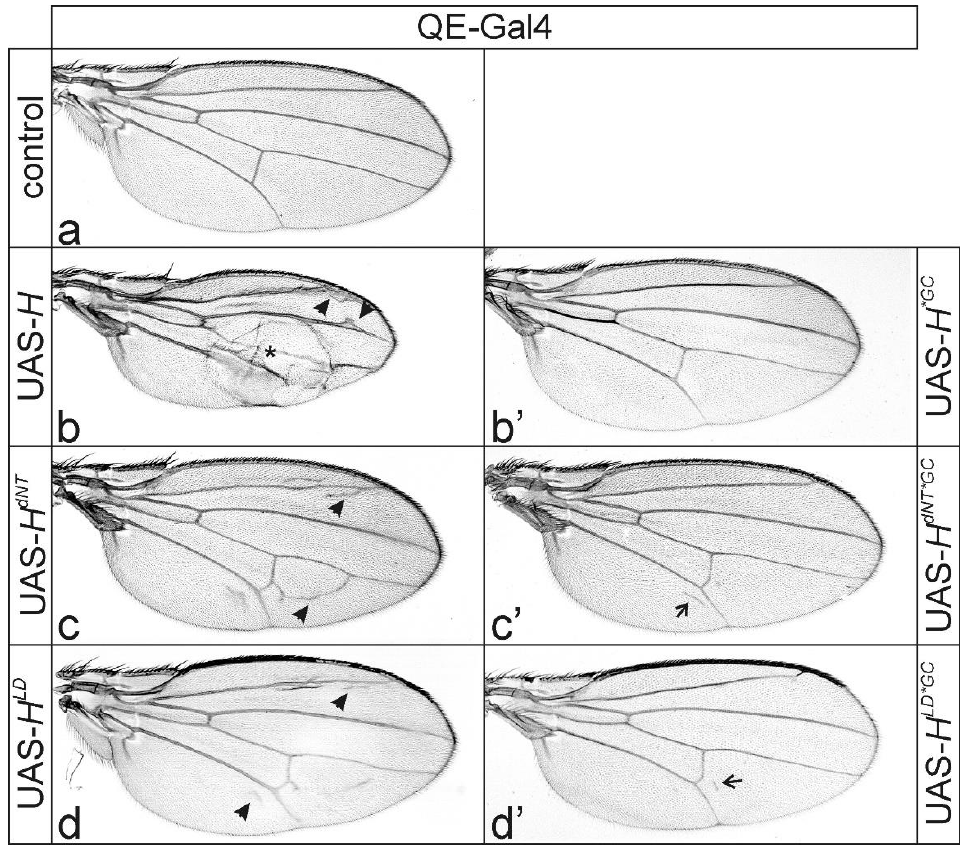
Figure 5. Overexpression of H* protein lacking Su(H) and co-repressor binding ability in the developing wing blade. ( a – d’ ) UAS- H* transgenes, as indicated, were induced at 25 °C with QE-Gal4 in presumptive wing tissue. ( a ) UAS-GFP served as control. ( b ) Whereas wild type H induced wing blisters (asterisk) and thickened veins (arrowheads), H dNT*GC ( c ) and H LD*GC ( d ) isoforms induced ectopic veinlets (arrowheads point to examples). ( b’ – d’ ) Overexpression of the respective H* protein isoforms that in addition lack Gro and CtBP co-repressor binding (*GC; see Figure 1a). Overall, the wings resembled the control. However, minute veinlets may appear in the developing wing blade. Examples are shown for ( c’ ) H dNT*GC and ( d’ ) H LD*GC (arrows). Female wings are shown.